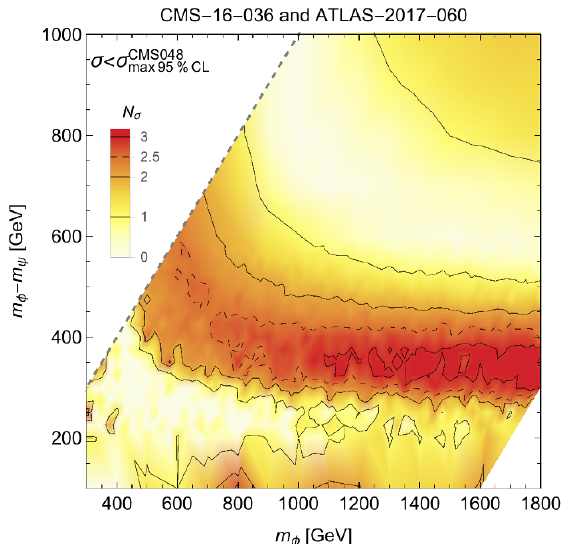
Figure 3 . Best-(cid:12)t signi(cid:12)cance for the model in the m (cid:30) =m (cid:30) (cid:0) m mass plane, obtained combining the CMS jets+ M T 2 search [3] and the ATLAS monojet search [7]. The corresponding best-(cid:12)t cross section is O (0 : 35 pb) in the region with highest signi(cid:12)cance.